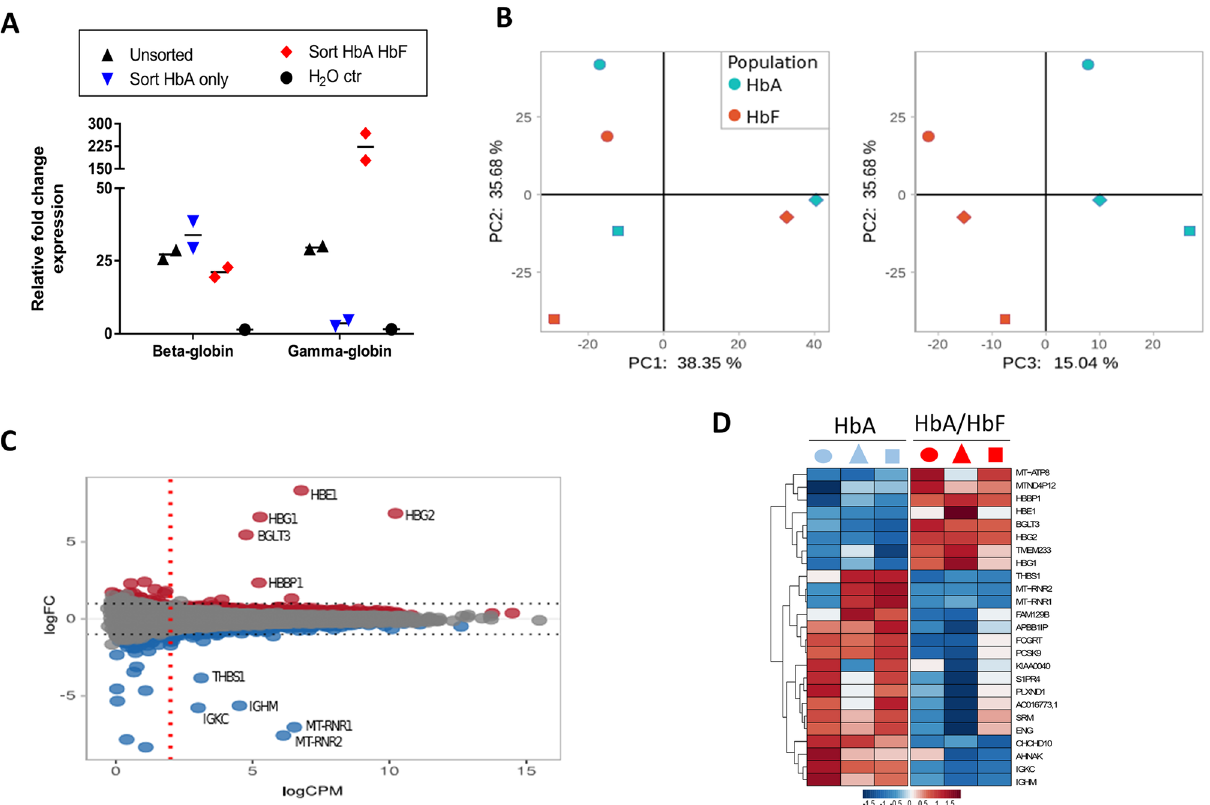
Figure 3. The RNA expression profile between sorted HbA and HbA/HbF expressing erythroblasts is highly similar. Erythroblasts cultured from three independent donors were stained for HBB1 and HBG1/2 and the HBB1 and HBB1/HBG1/2 expressing erythroblasts were FACS-sorted after which RNA was isolated and subjected to RNA-sequencing as indicated in material and methods. ( A ) RT-qPCR using primers for beta- globin (HBB1) and gamma-globin (HBG1/2) on mRNA isolated from HbA (blue) and HbA/HbF (red) sorted populations, unsorted (black) and water control (black circles) as indicated. The relative fold change expression to the water control is depicted. ( B ) principle component analysis showing the variation between the sorted populations in the three first components. ( C ) RNA sequencing expression analysis depicted as log2 fold change (y-axis) against average count per million reads per gene (CPM, x-axis). Differentially expressed genes crossing the threshold of p < 0.01 are indicated in red for upregulated and blue for downregulated (dark spots represent unchanged RNAs). The blue lines indicate the log2 fold change cut-off (CPM), − 1 < gene > 1 and the red line indicates the CPM cutoff (> 2). ( D ) Heatmap depicting z-scores of the 25 differentially expressed RNAs clustered (rows and columns) using one-minus-Pearson-correlation with average